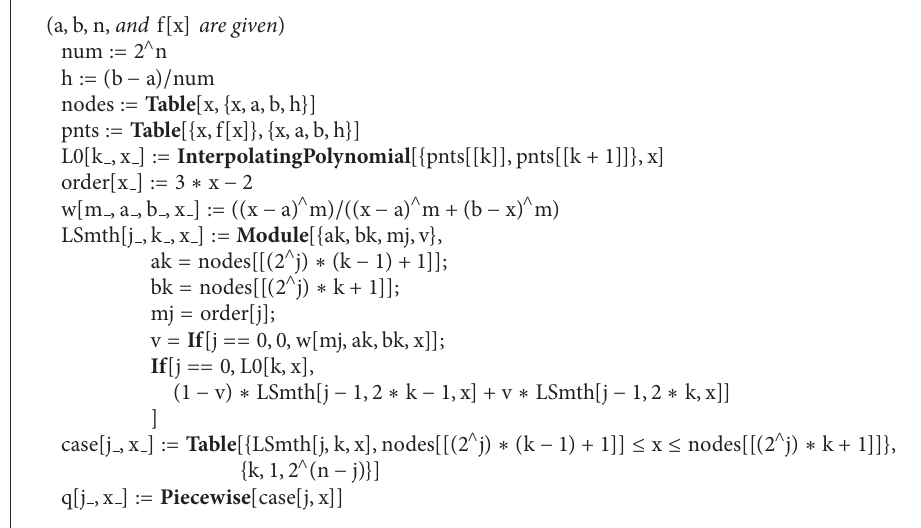
Algorithm 1: Mathematica code for the presented